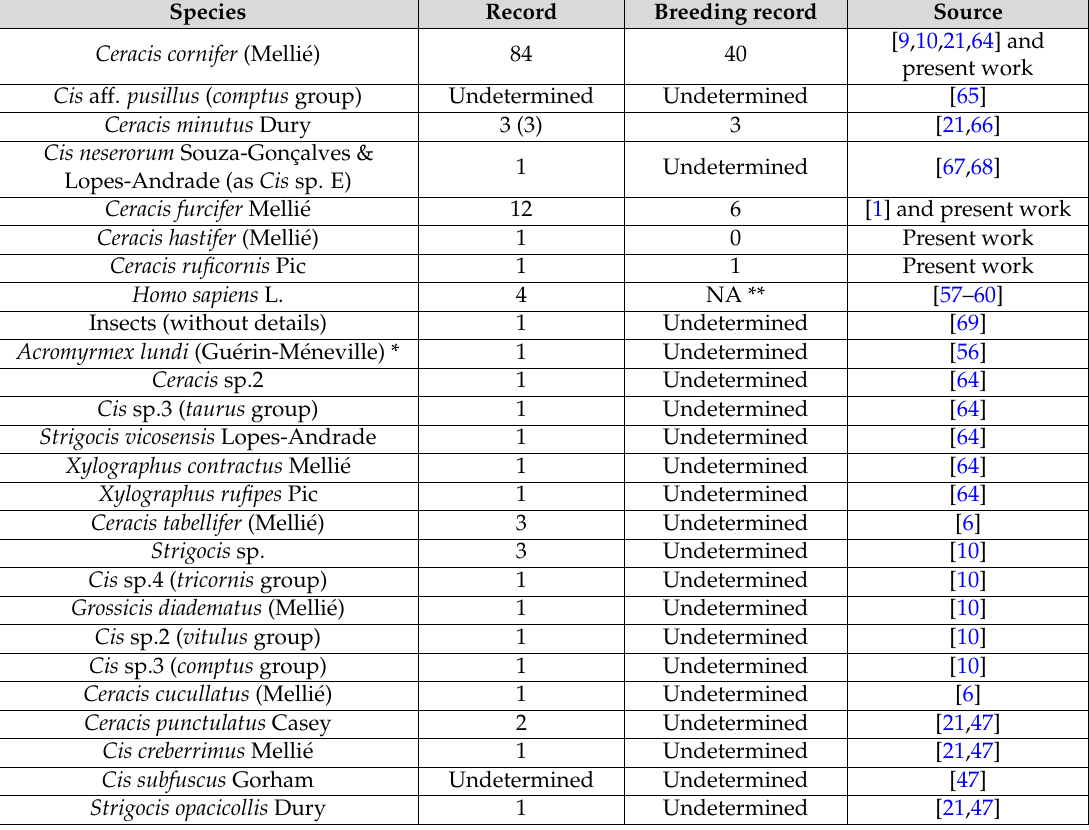
Table A1. List of animals feeding on basidiomes of Pycnoporus sanguineus . The numbering of each morphospecies cited below is the same used in the corresponding source.